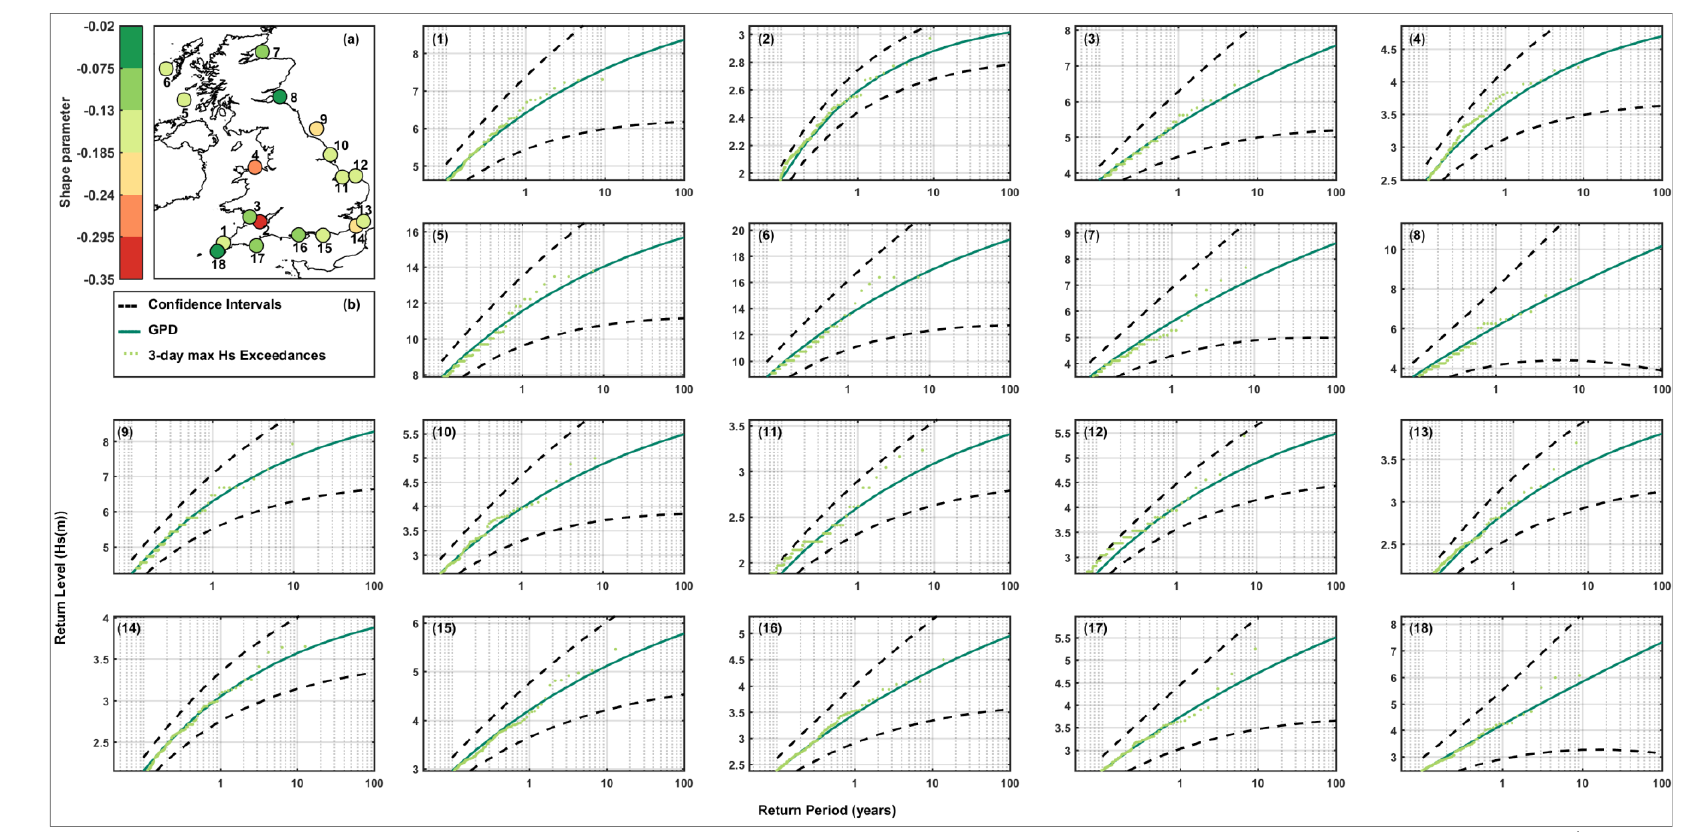
Figure 2. Generalized Pareto Distribution (GPD) fits are shown for each of the sites along with their confidence intervals (95%). The number in brackets indicates the site identity number. Both colours and dots represent the shape parameter for each location on a UK map ( a ), and there is a legend for the GPD plots ( b ).